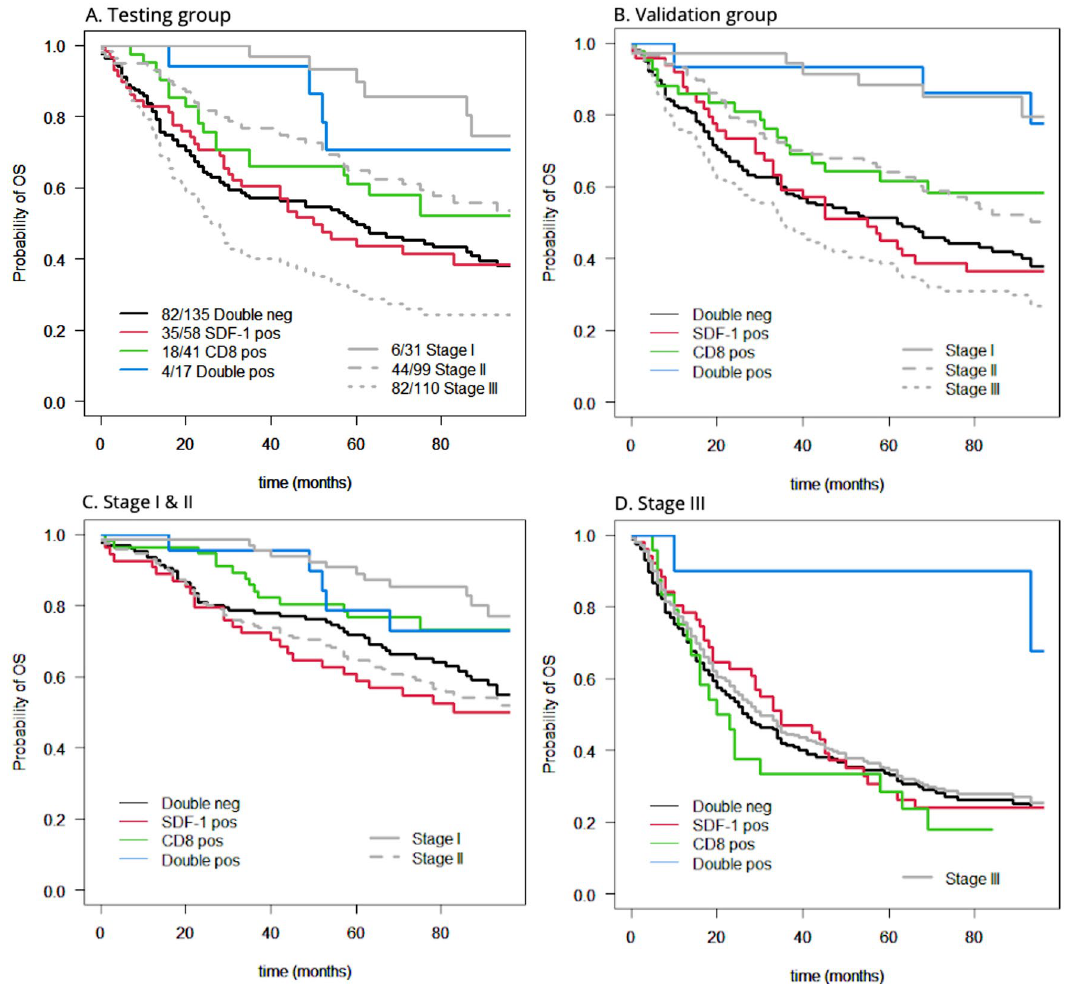
Figure 3. Kaplan–Meier overall survival curves according to CD8+ T-cell density and SDF-1 expression after stratifying the patients in testing and validation groups as well as in nodal negative and nodal positive groups. Kaplan–Meier overall survival curves after stratifying the patients in testing and validation groups as well as in nodal negative and nodal positive groups. ( A ) (Testing group): in this group the overall p value is 0.040 and the survival of patients with double positive markers is the only one, which (almost) reaches p values < 0.05 in comparison to the case with negative CD8+ T-cells. ( B ) (Validation group): Here the overall p value is 0.009. The survival of patients with double positive markers is the only one that reaches p values < 0.05 in comparison to the case with negative CD8+ T-cells. ( C ) (Stage I&II): No combination reaches the adjusted for multiple comparison p values < 0.05, even though overall p is 0.04. ( D ) (Stage III): With an overall p value of 0.02, the combination of high density of CD8+ T-cells and high expression of SDF-1 has an outstanding positive impact in the survival of patients with CRC at stage